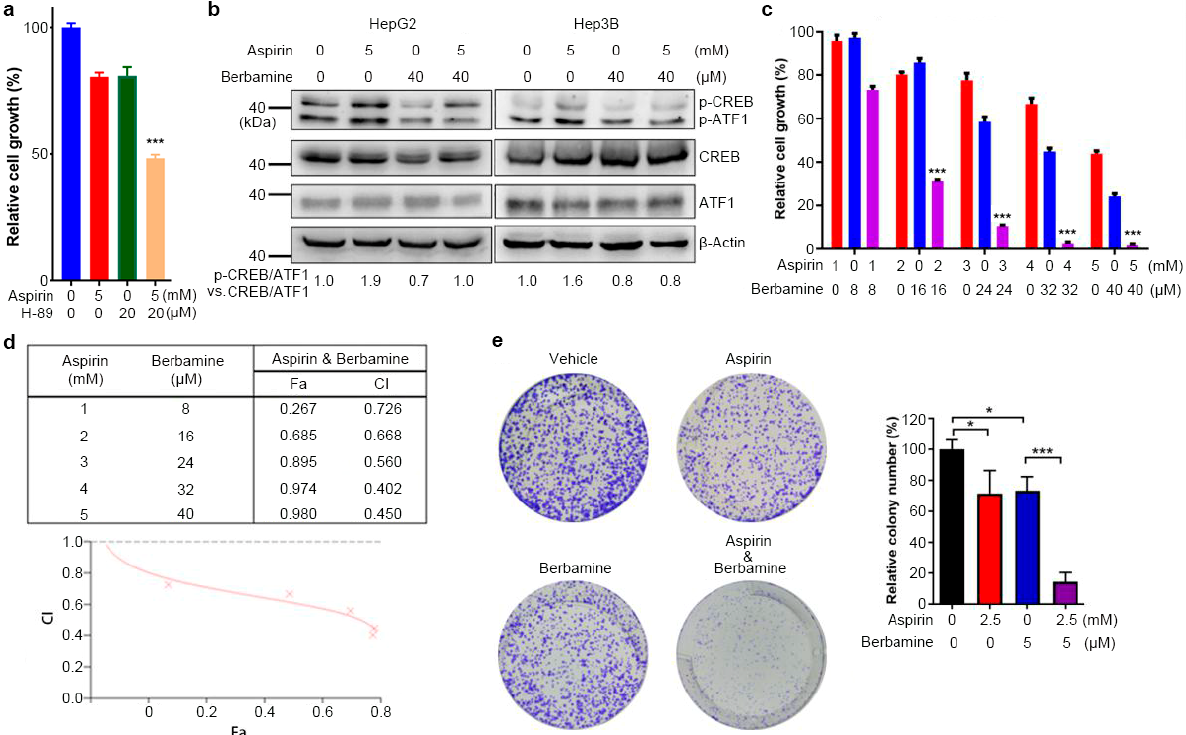
Figure 5. Berbamine inhibits the induction of CREB/ATF1 phosphorylation by aspirin and synergizes with aspirin to inhibit HCC cell growth. ( a ) HepG2 cells were treated with aspirin alone or in combination with H-89 for 48 h, followed by CCK-8 assays. The relative cell growth was plotted. Values represent means ± SD ( n = 5). ***, p < 0.001, compared to other groups. ( b ) HepG2 and Hep3B cells were treated with aspirin individually or in combination with berbamine for 32 h, followed by Western blot analysis of indicated proteins. The relative levels of p-CREB/ATF1 normalized to total CREB/ATF1 were shown. ( c ) HepG2 cells were treated with aspirin alone or in combination with berbamine for 48 h, followed by CCK-8 assays. The relative cell growth was plotted. The cell viability in aspirin- and berbamine-untreated group was set as 100%. Values represent means ± SD ( n = 5). ***, p < 0.001, compared to mono-treatment. ( d ) The combination index (CI) was identified using CalcuSyn software and shown by the Fa-CI plot. ( e ) HepG2 cells were treated with aspirin and/or berbamine for 48 h. The cells were incubated for another 7 days, followed by crystal violet staining. The relative colony formation was plotted. Values represent means ± SD ( n = 3). *, p < 0.05. ***, p < 0.001.